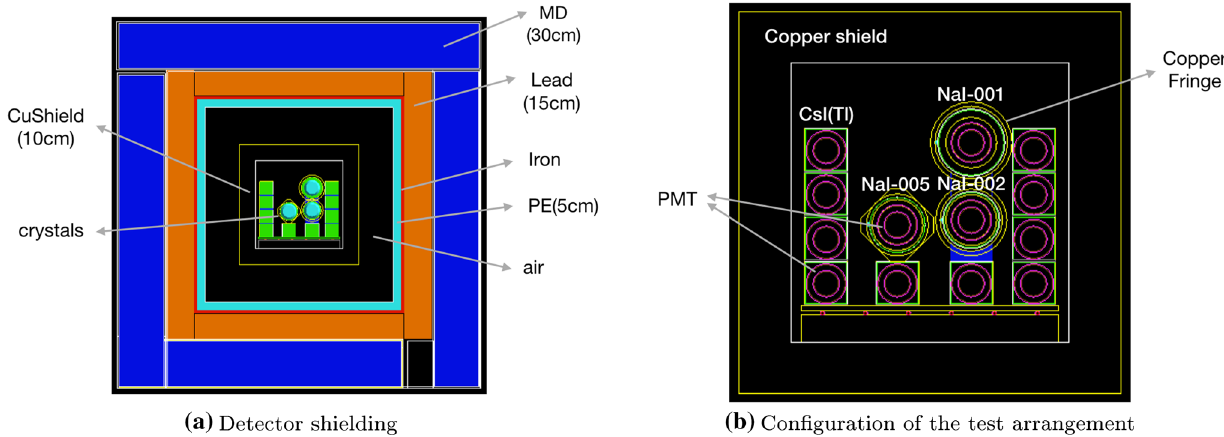
Fig. 1 Schematic view of detector shielding ( a ): muon detector (MD), polyethylene (PE), and copper shield (CuShield). Configuration for three NaI(Tl) crystals with the CsI(Tl) crystal array ( b ) Table 1 Light yield and measured background rates from internal radioactive contaminants in the NaI(Tl) crystal [14] Crystal